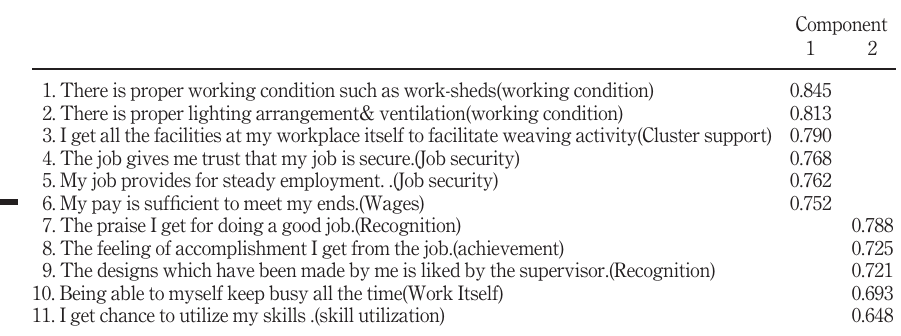
Table 4. Result of rotated component matrix for job